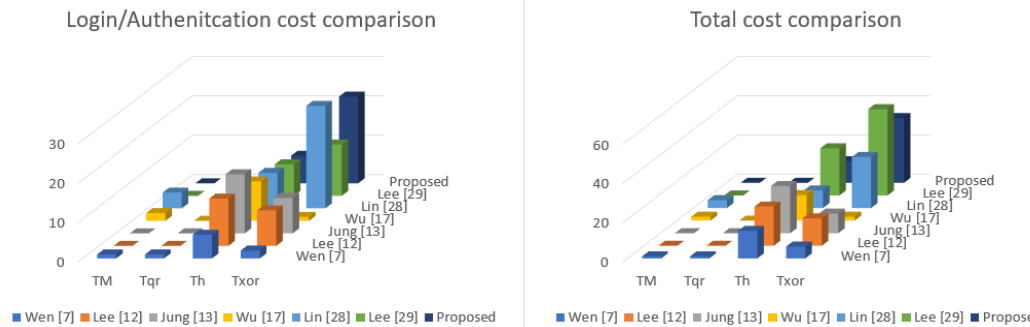
Figure 4. Performance comparison charts.